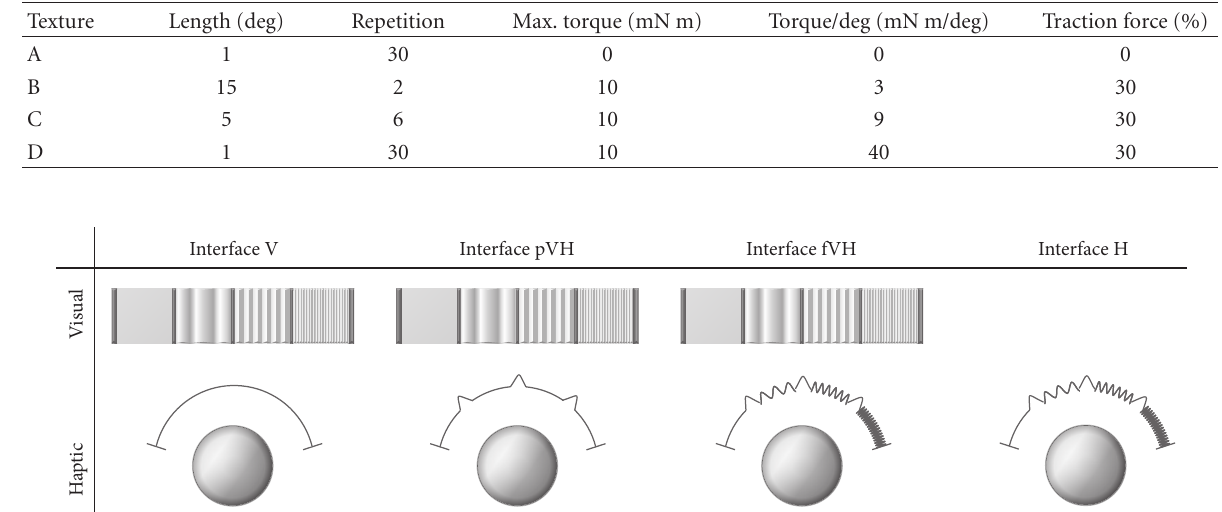
Table 1: Specification of the haptic e ff ects used in the experiment.